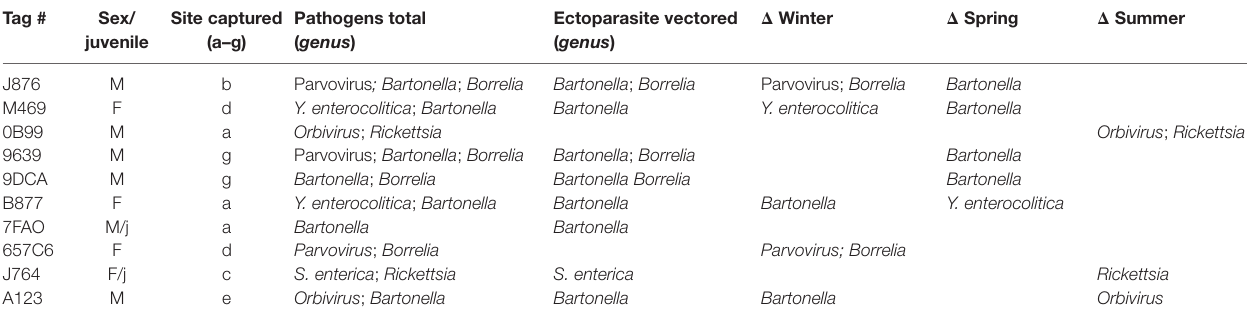
tABlE 2 | Anticipated